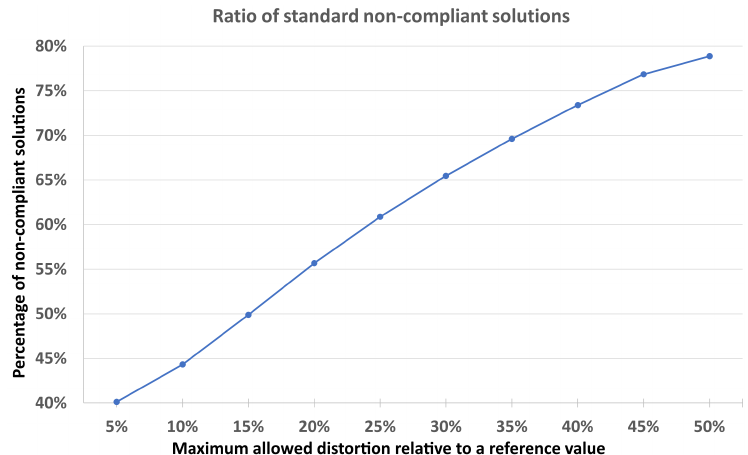
Figure 7. The ratios of standard non-compliant solutions for various distortions. The 0% distortion denotes ∆ <